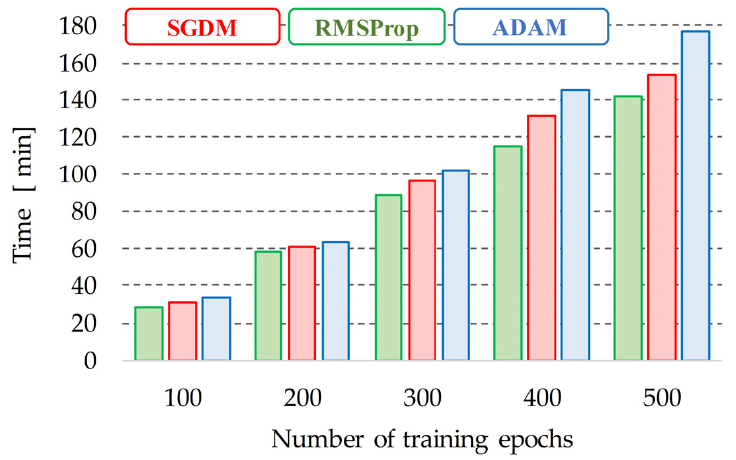
Figure 3. Influence of the CNN learning method algorithm on the time of training process.